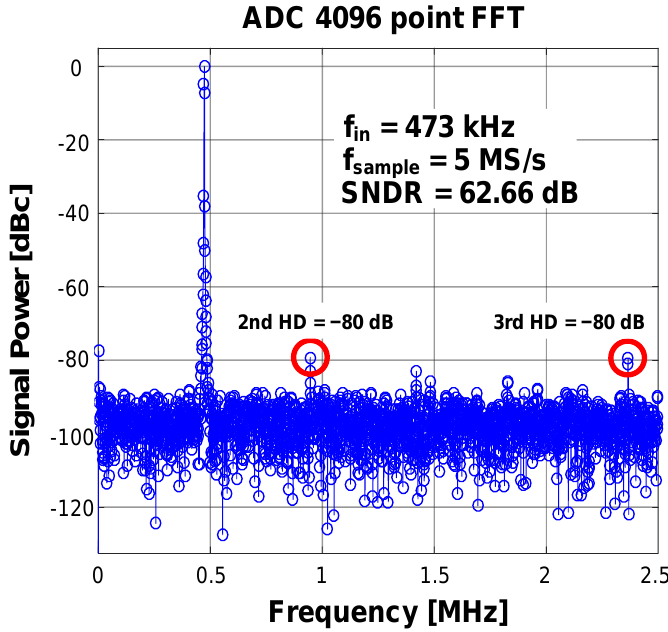
Figure 10. ( a ) Histogram of measured impedance over 1000 measurements. ( b ) Dynamic range measurement from 30 kHz to 1.25 MHz.